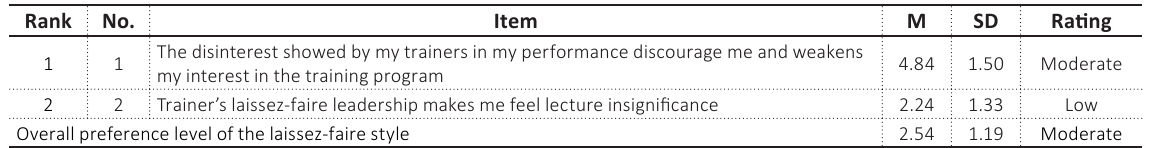
Table 8. Means and standard deviations of respondents’ responses to items measuring the laissez- faire style in descending order of means